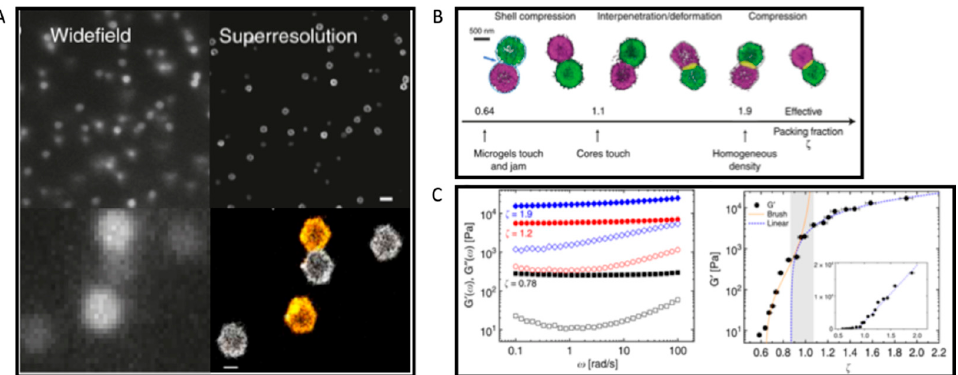
Figure 6. ( A ) . Images of PNIPAM microgels labeled with Alexa Fluor ®647 dye, comparing conven- tional wide-field and dSTORM super-resolution images (two-color image) of glass sample ( ζ = 1.89, c = 2.36 wt%) (scale bar, 2 µm in the upper images and 500 nm in the lower images) ( B ). Two-color microscopy of microgel pairs. Evolution of the interaction with the increase in the effective packing fraction ζ (from left to right, ζ = 0.86, 1.01, 1.26, 1.50, 1.89, 2.13). ( C ) . (left graph) Elastic modulus, G ′ ( ω ) (full symbols), and viscous modulus, G ′′ ( ω ) (open symbols), as a function of frequency ω for different packing fractions, ranging from jammed to overpacked ( ζ = 0.78 to 1.9). (right graph) Elas- tic modulus G’ at constant frequency ( ω = 1.2 rad/s) as a function of packing fraction ζ fitted with the Brush model (orange, dotted line) at lower ζ and with a linear function at higher ζ ( ζ ≥ ζ c = 0.87). The shaded area marks the crossover between the regime controlled by shell compression to the one governed by core–core interactions. (Inset corresponds to the linear representation of the same data.) (Adapted from Conley et al., Nature Communications, Jun 2019, 2436; DOI: 10.1038/s41467-019- 10181-5; licensed under CC BY 4.0 (open access) [139].